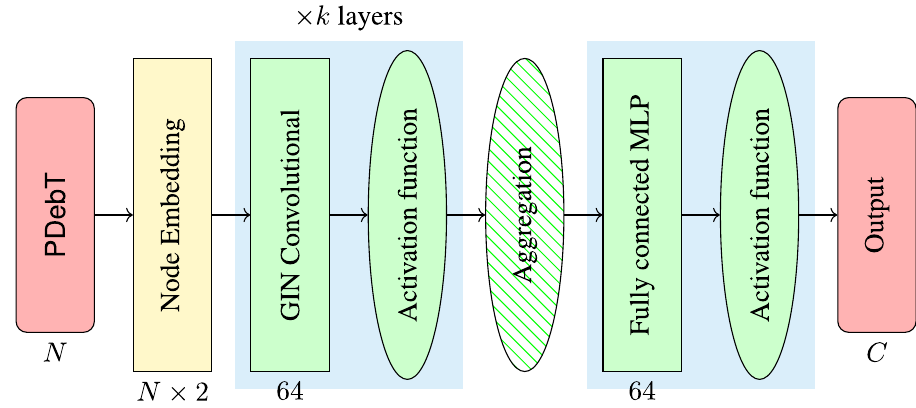
Fig. 2 1GNN model: GNN architecture for computing the polarization degree of a Pruned Debate